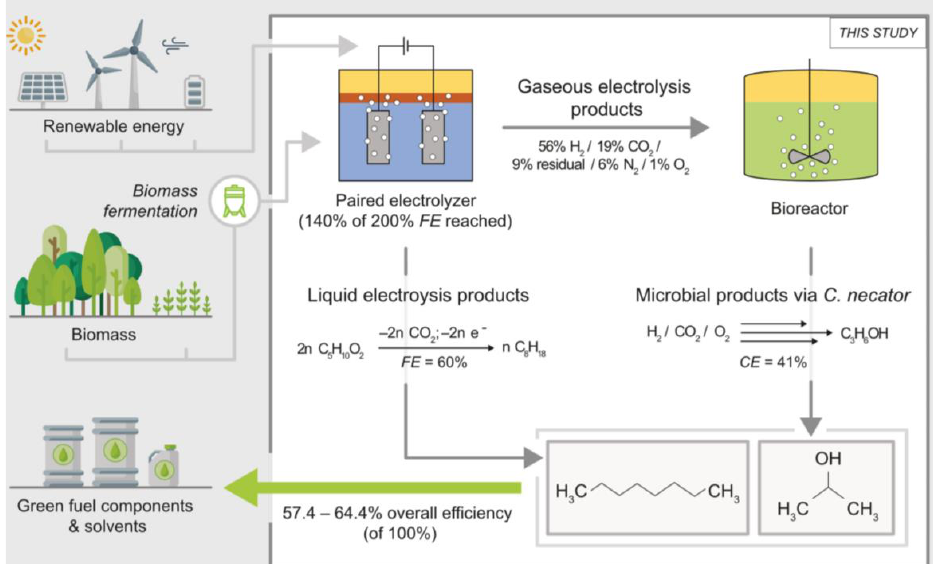
Figure 4. Schematic illustration of efficient generation of green fuels and solvents by integrating electrosynthesis and biosynthesis: carboxylic acids that originate from the mixed acid fermentation of biomass are utilized as substrate for Kolbe electrolysis process powered by renewables. Kolbe electrolysis then takes place in the hybrid electrolyzer and generates liquid products (n-octane) anodically and hydrogen cathodically. The resulted efficiencies of the process steps and the overall efficiency are shown (CE = Carbon efficiency, FE = Faradaic efficiency). Reproduced with permission [82], Copyright 2022, Wiley Publishing